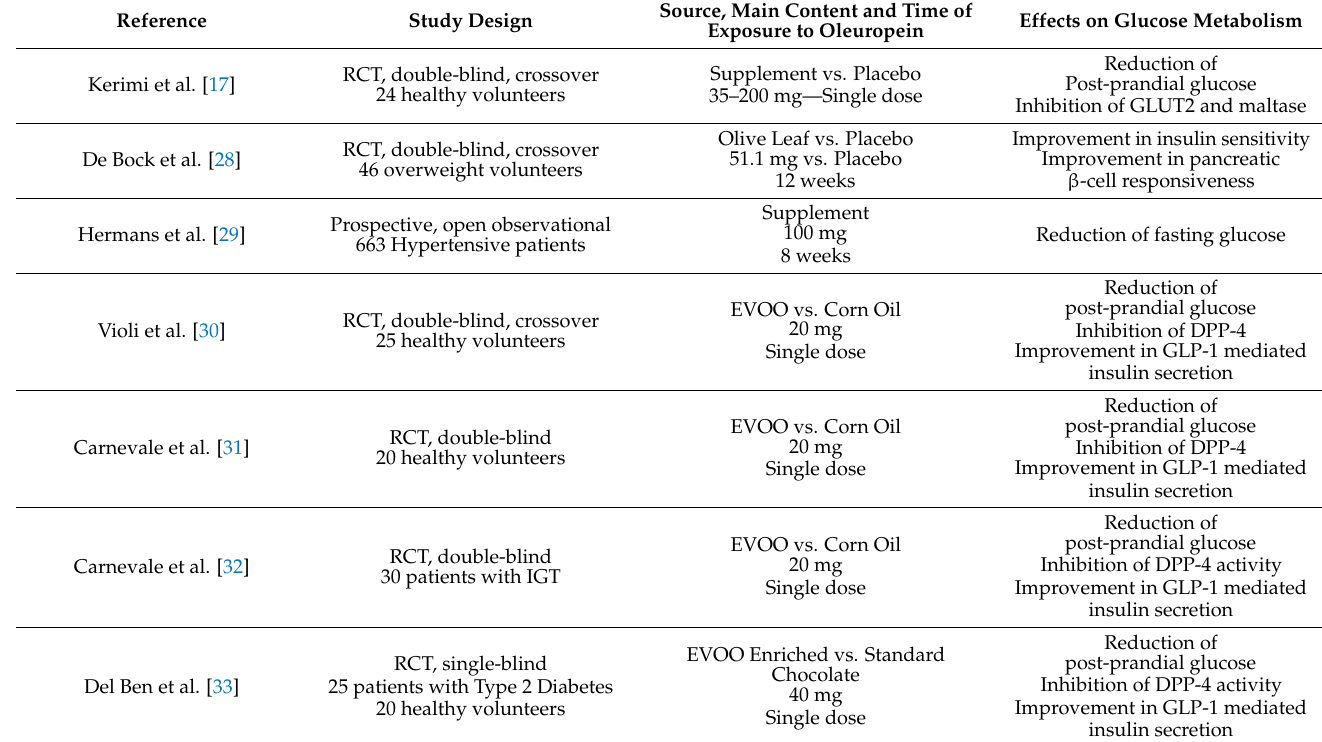
Table 2. Clinical trials that examined the effects of oleuropein on glucose